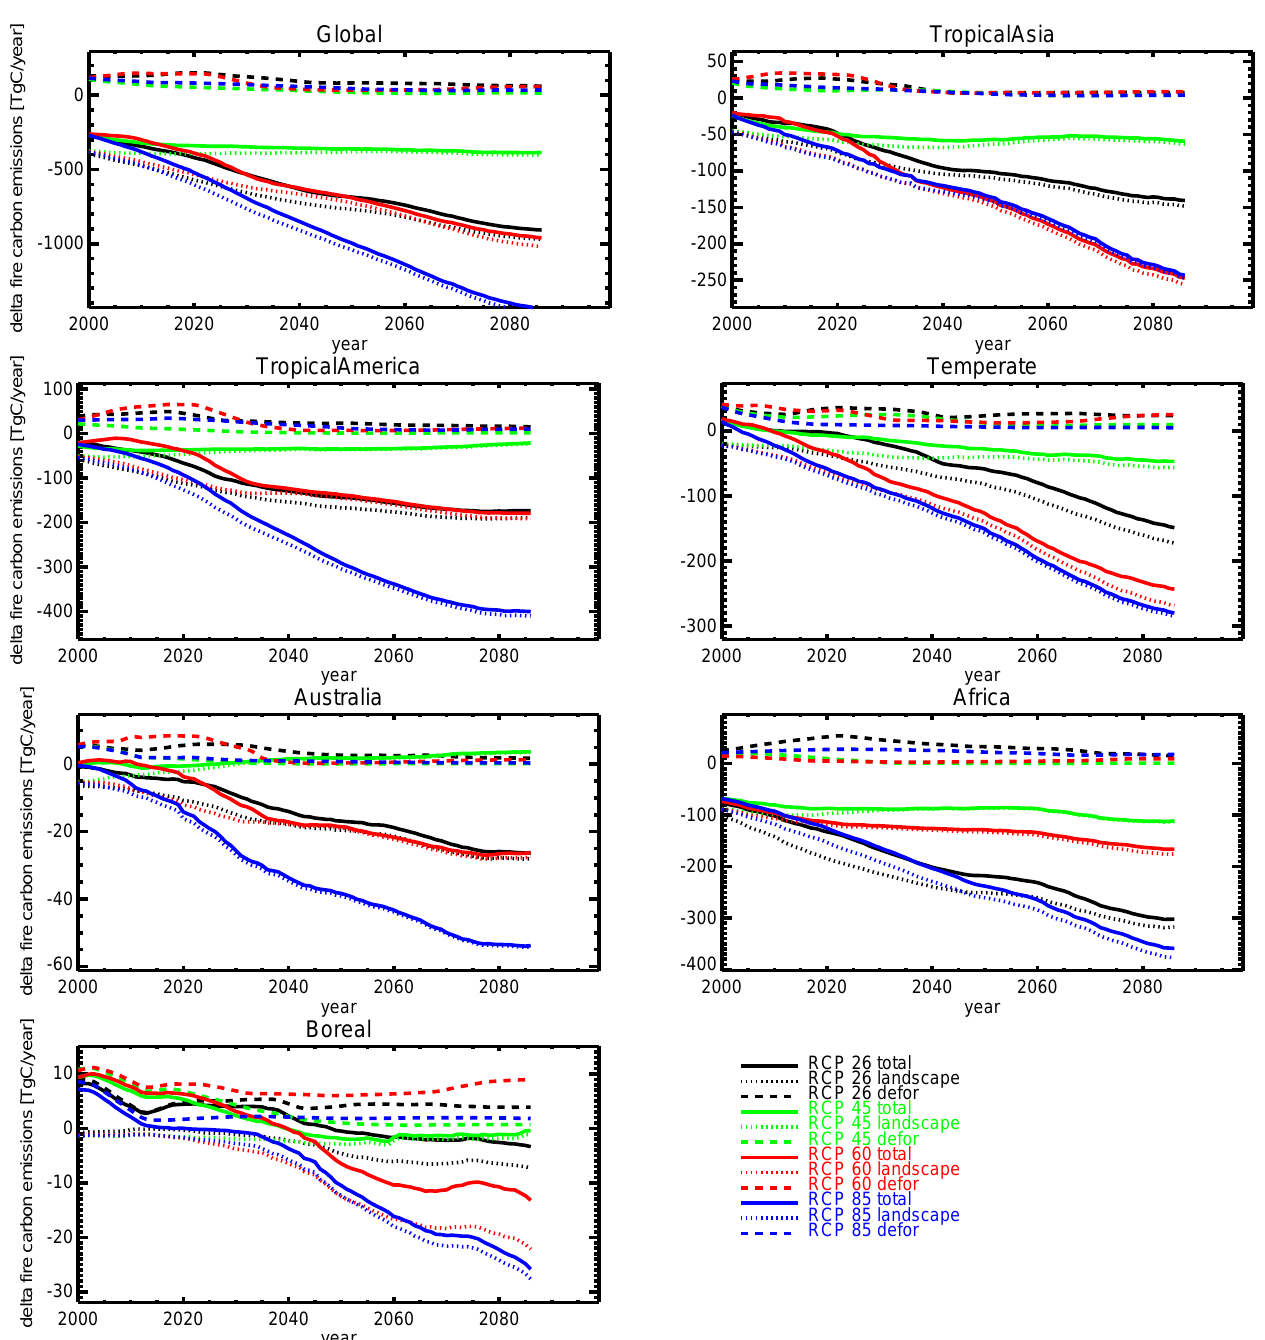
Fig. 9. Change in annual mean landscape, deforestation, and total (landscape plus deforestation) fire emissions in [TgCyr − 1 ] introduced by different harvest/land cover change projections (RCP 26, 45, 60, 85) for different major world regions. Simulations with transient varying forcings are compared to a control simulation with constant harvest/land cover. The timeseries were smoothed with a 25yr running mean. Similar to van der Werf et al. (2010) the different regions were composed of BONA and BOAS (Boreal), TENA, EURO, CEAS (Temperate), CEAM, NHSA, and SHSA (Tropical America), MIDE, NHAF, and SHAF (Africa), SEAS and EQAS (Tropical Asia), and AUST for Australia (see also Table